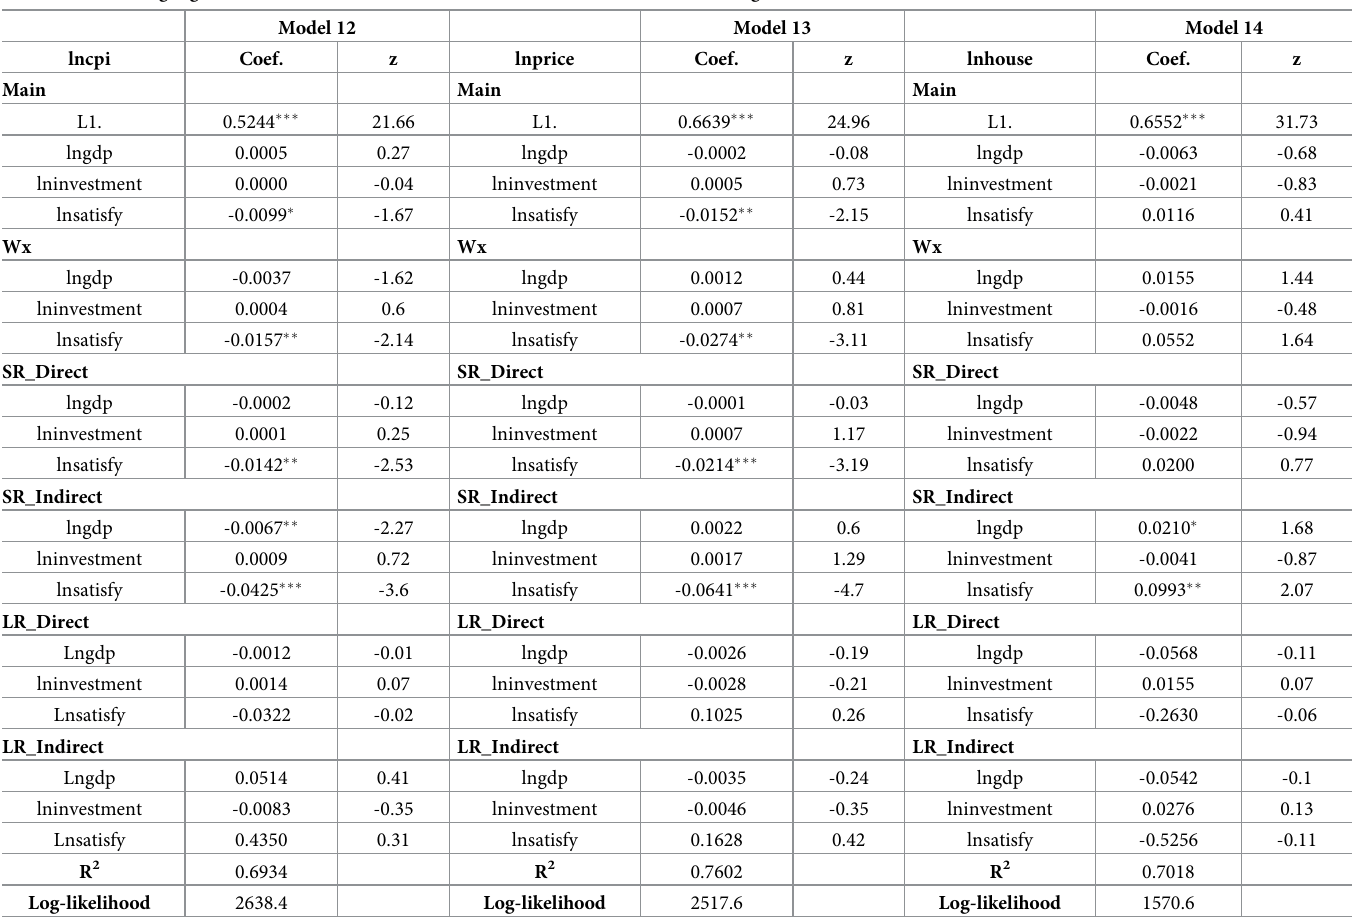
Table 11. SDM_Lag regression results for urban tourist satisfaction and urban cost of